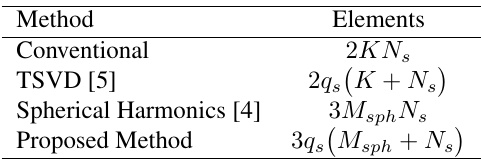
Figure 2: Current modes in a group corresponding to the first, second and third singular value of matrix C x example structure given in Fig 1. Table 1: Number of elements for aggregation matrices of one group with different compression methods.